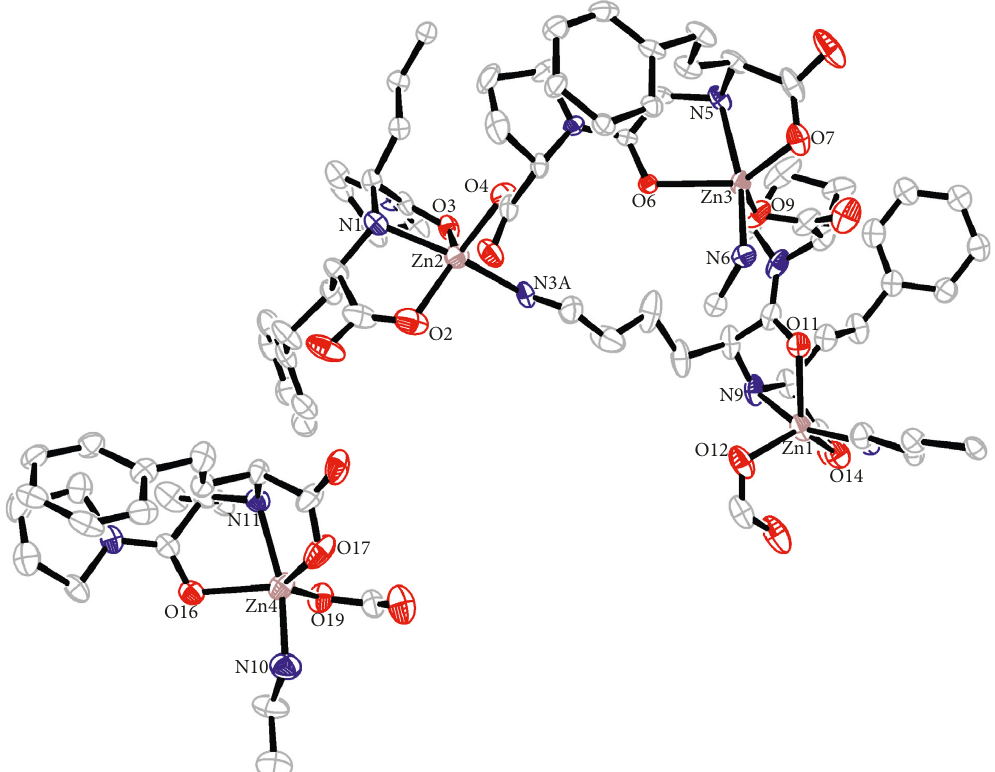
Figure 6: The asymmetric unit of the LISZn2 complex. Thermal ellipsoids are drawn at the 30% probability level. Some atoms are omitted for